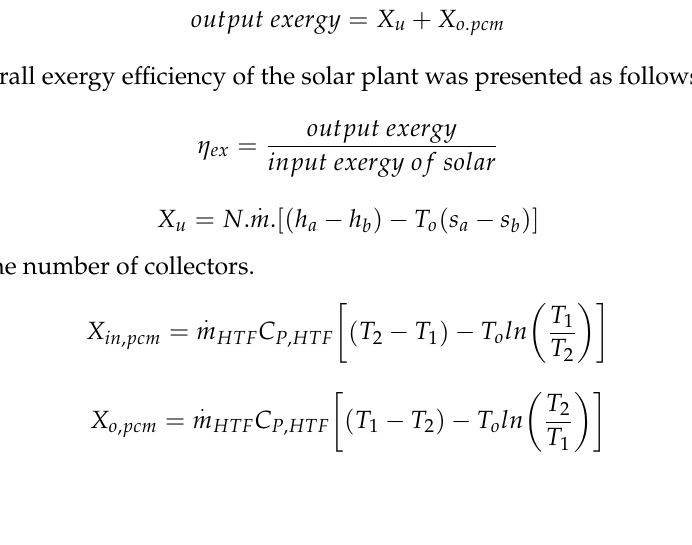
Table 3. Results of some of the studies presented on solar power generation and the PCM used. Authors